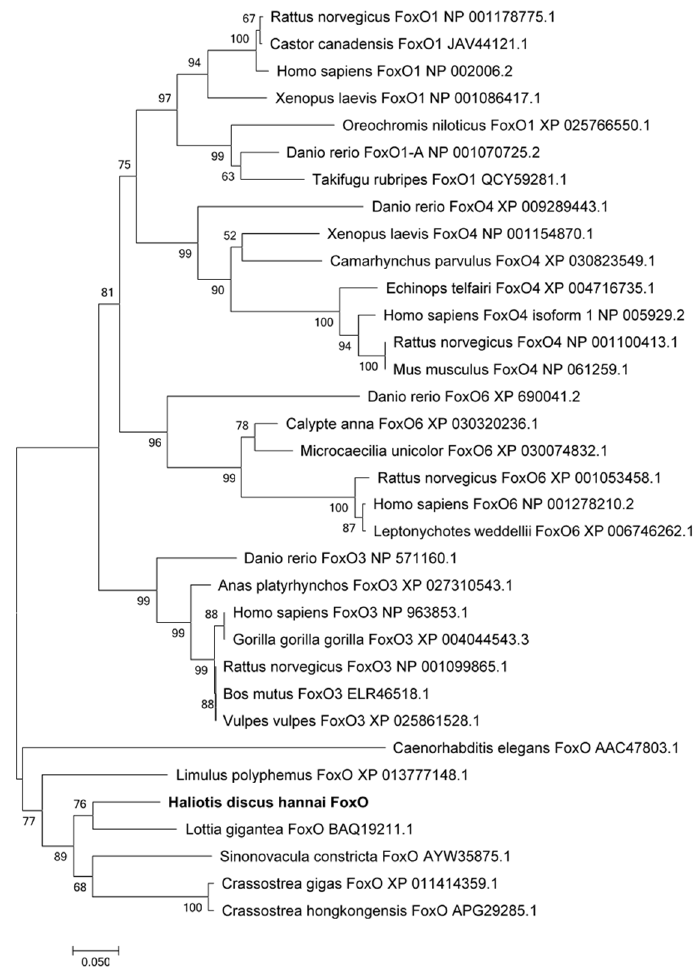
Figure 1. Phylogenetic tree based on the sequences of forkhead (FH) domains of forkhead box Os (FoxOs) from abalone and other species.